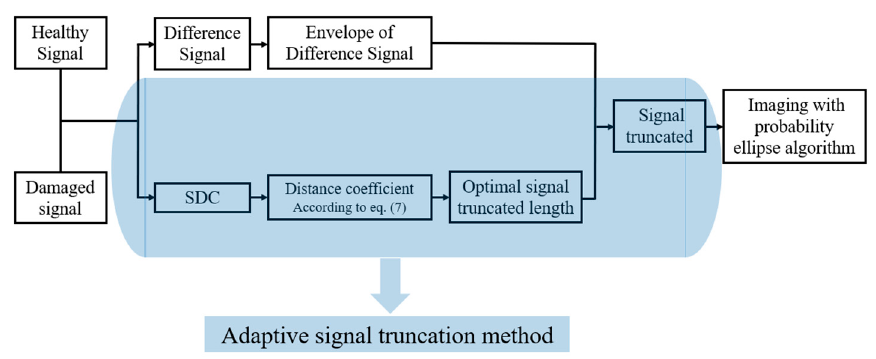
Figure 4. Imaging process of the probabilistic elliptical algorithm based on the adaptive signal truncation method.